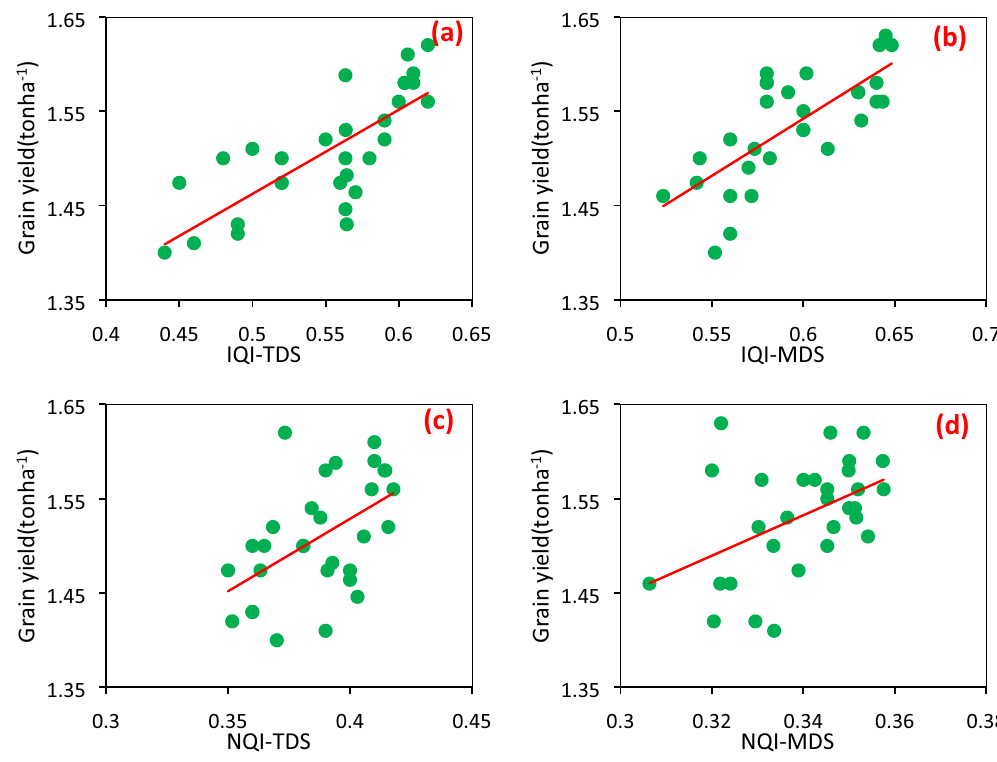
Figure 3. Wheat grain yield versus IQI-TDS ( a ), IQI-MDS ( b ), NQI-TDS ( c ), and NQI-MDS ( d